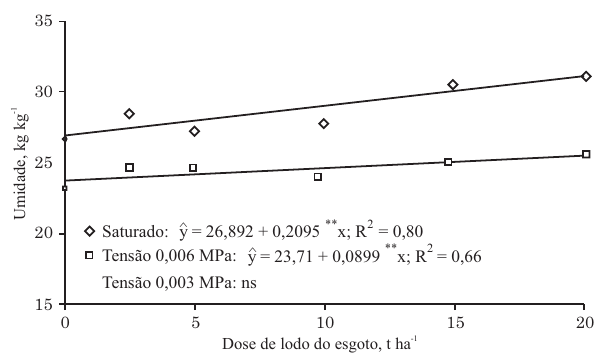
Figura 4. Umidade do solo em função de doses de lodo de esgoto, seis meses após sua aplicação. ** = significativo a 1 %, n = não